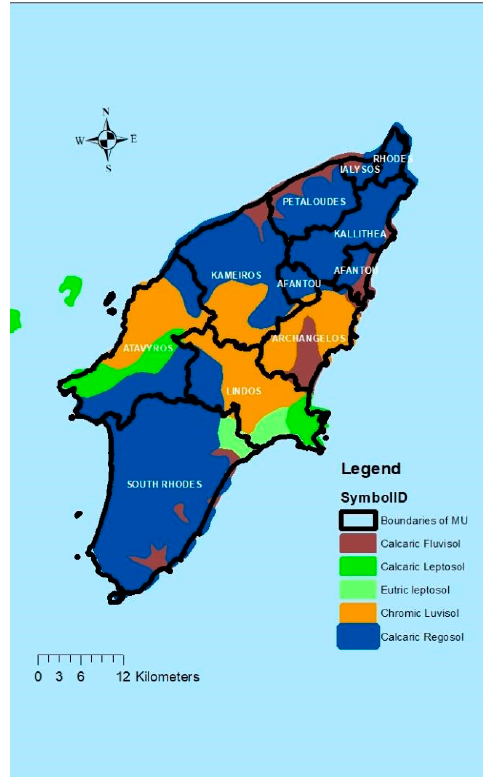
Figure 1. Soil map of Rhodes at an MU resolution. Source: Soil map from [29], MU map from [32].